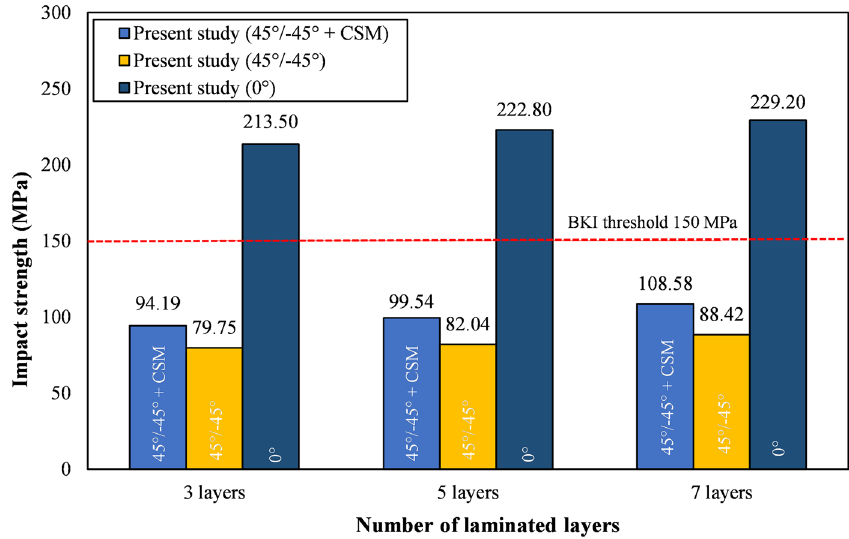
Figure 10: Comparison of impact test results under di ff erent numbers laminated